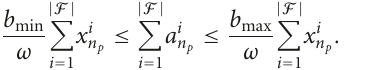
Figure 3: Illustration for vectors a n